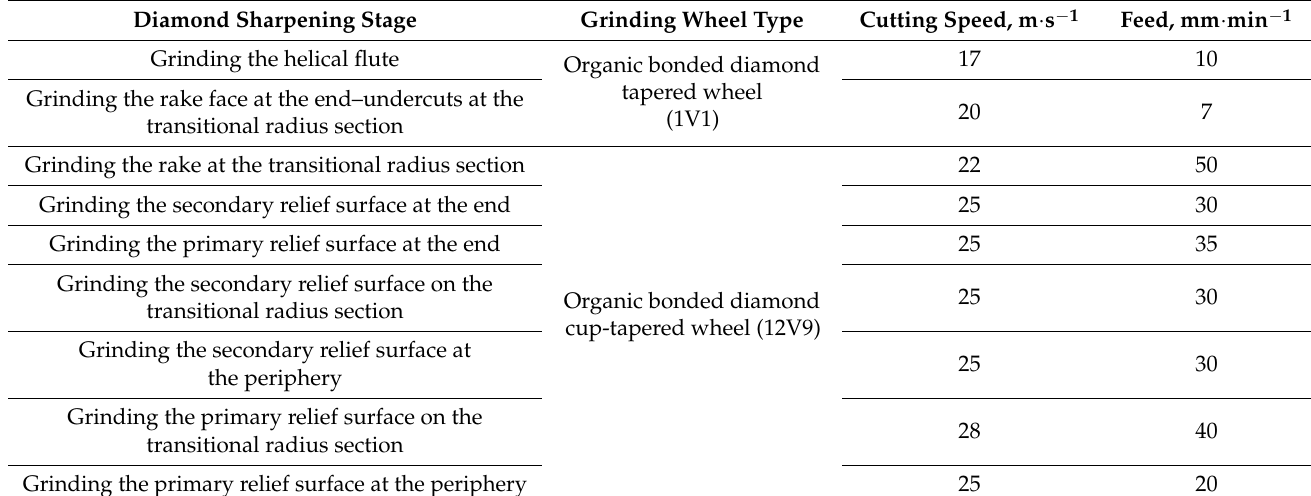
Table 2. Modes of ceramic end mill diamond grinding and the type of used grinding